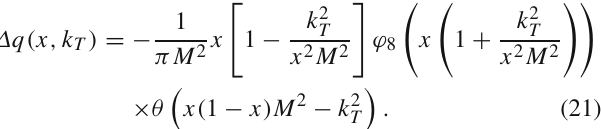
Fig. 8 The x -distribution of total TMD polarized sea quarks at Q 2 1 GeV 2